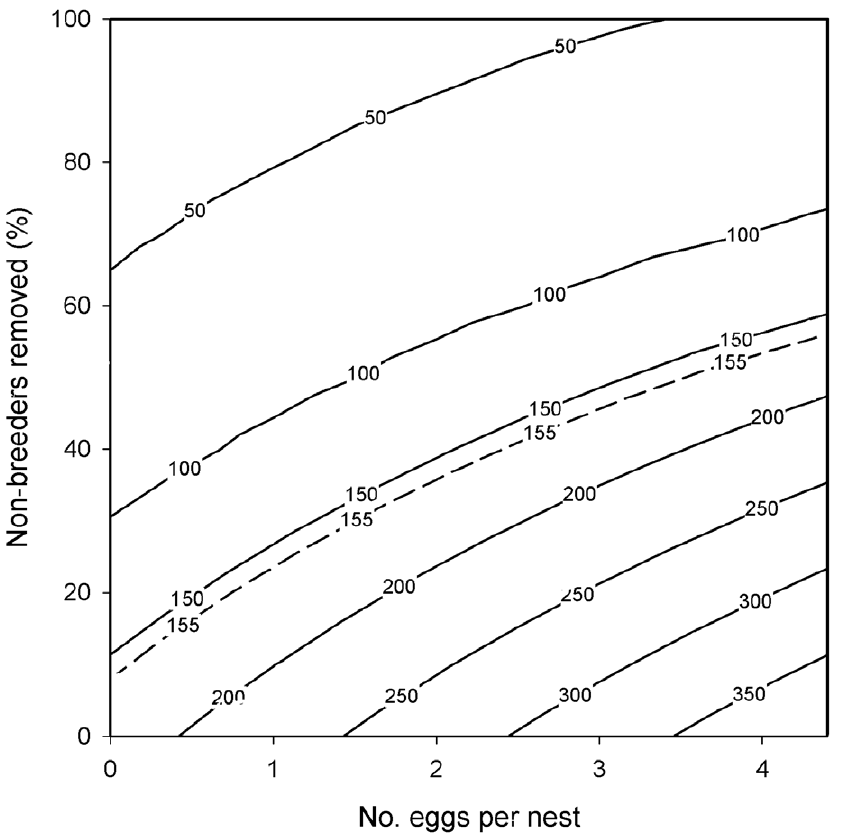
Figure 4. The projected stable population sizes, estimated as the mean population size between years 36 and 50, when subject to sustained population management over a 50 year period. Management comprised combined clutch manipulations (4, 3, 2, 1 or 0 eggs per nest) and the removal of non-breeding individuals (100, 80, 60, 40, 20 or 0%). The dashed line represents the target threshold of 155 individuals.